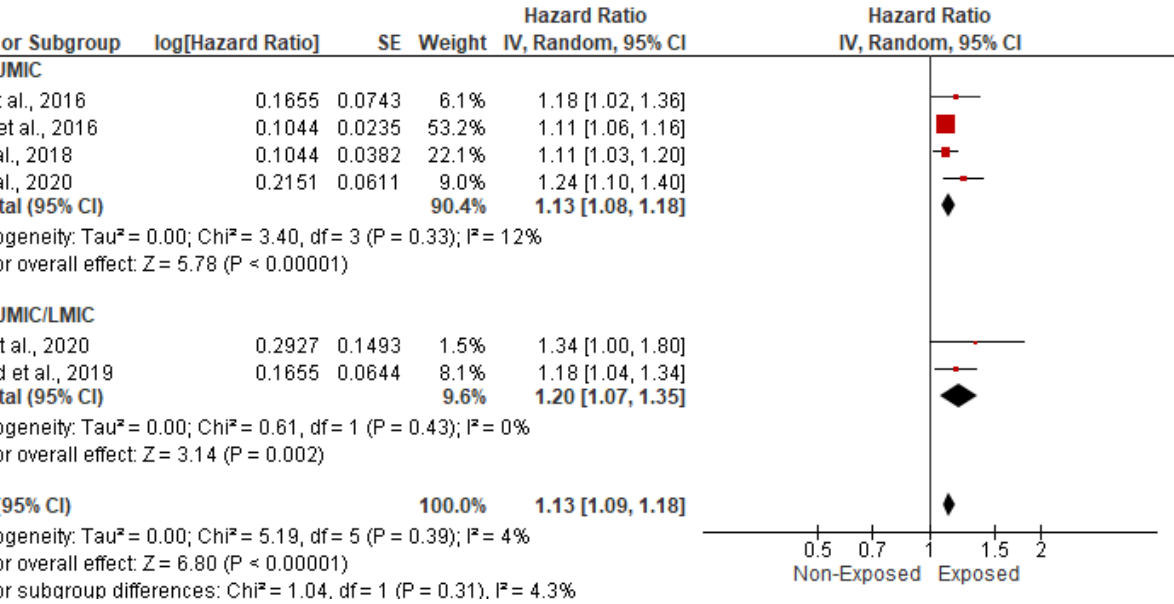
Figure 3. After using the trim and fill method of Duvall and Tweedie, a funnel plot of the observed and plotted studies for assessing the association between HAP and CVD-related mortality. The white circles represent the observed studies, and the black circles represent the plotted studies.